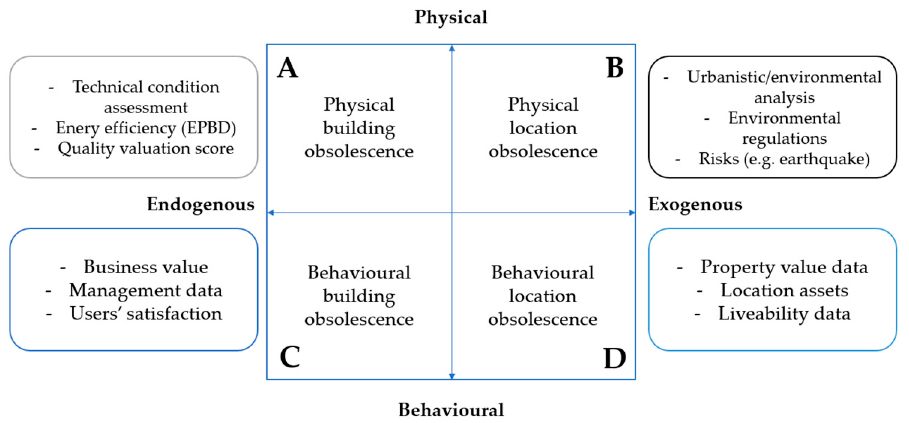
Figure 1. Extended diagram of the two main cause-effect dimensions of obsolescence (adapted from Thomsen and Van der Flier [28,29]). Copyright 2022 Copyright Informa UK Limited; Copyright 2011 Copyright Thomsen, A. and Van der Flier, K.